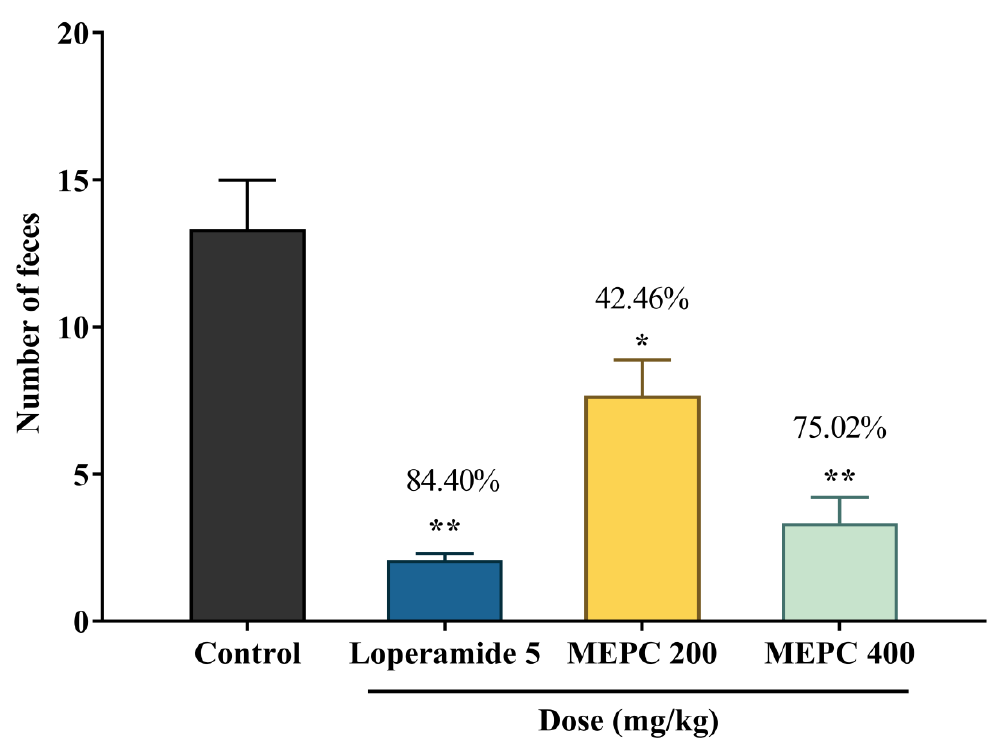
Figure 5. Antidiarrheal activity of methanol extract of P. calocarpa (MEPC) and loperamide in castor oil-induced diarrhea in mice. Values represented as mean ± SEM ( n = 5). * p < 0.01 and ** p < 0.001 considered as significantly different from the control (Dunnett’s test). Table 2. Antidiarrheal activity of methanol extract of P. calocarpa (MEPC) on intestinal motility in mice by charcoal as a